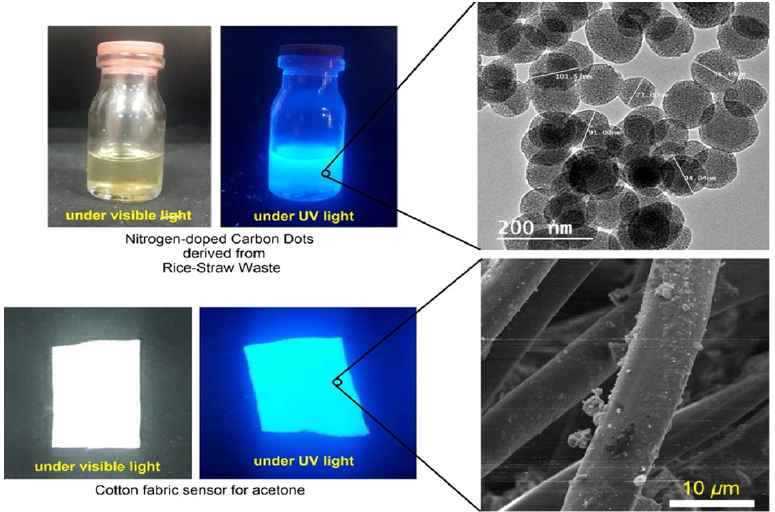
Figure 8. Visual diagrams of the replacement of carbon dots on the mask fabric and its UV light test. Reprinted with permission from Ref. [44]. Copyright 2022, Elsevier .